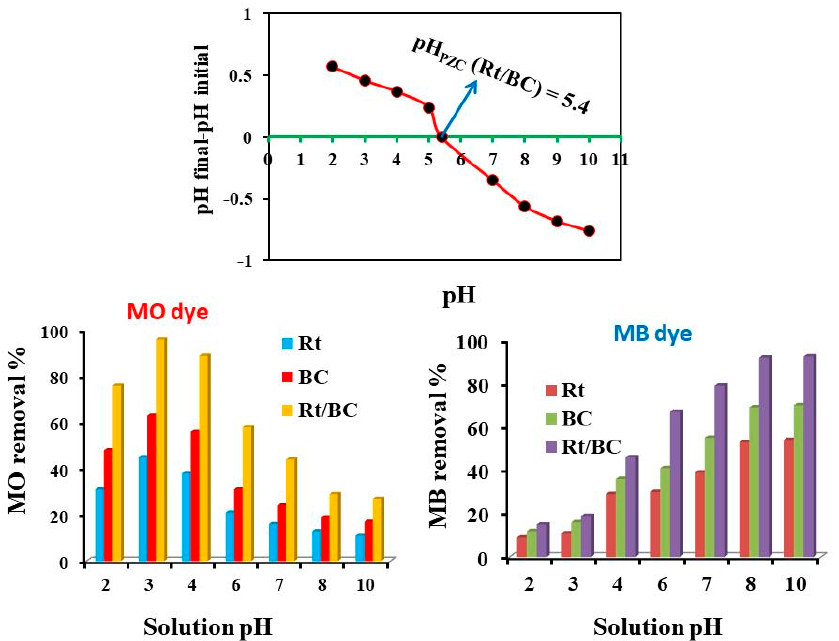
Figure 4. pH PZC of the Rt/BC composite and pH effect on MB and MO dyes adsorption on Rt/BC adsorbent. Rt/BC composite displayed a high removal performance for MO (96.7%) and MB (91.4%) at pH 3.0 and 8.0, respectively.